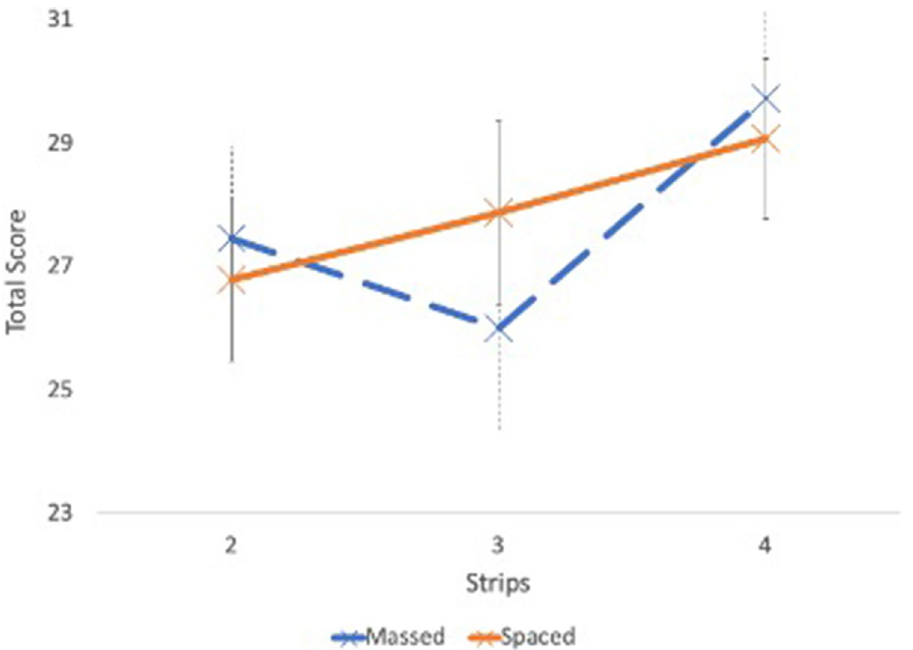
Figure 3. Mixed ANOVA test for Strips 2, 3 and 4 (Total